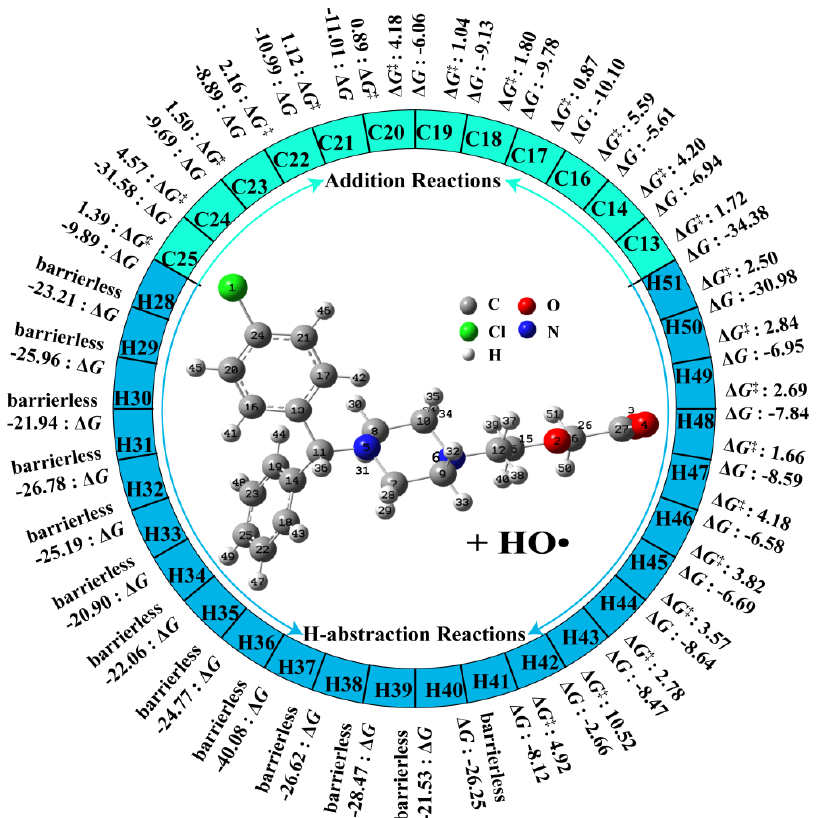
Figure 6. Addition and H-abstraction reaction pathways for reaction of CTZ with HO • (Δ G : Gibbs free energy change; Δ G ‡ : activation free energy; unit in kcal mol −1 ). free energy change; ∆ G ‡ : activation free energy; unit in kcal mol − 1